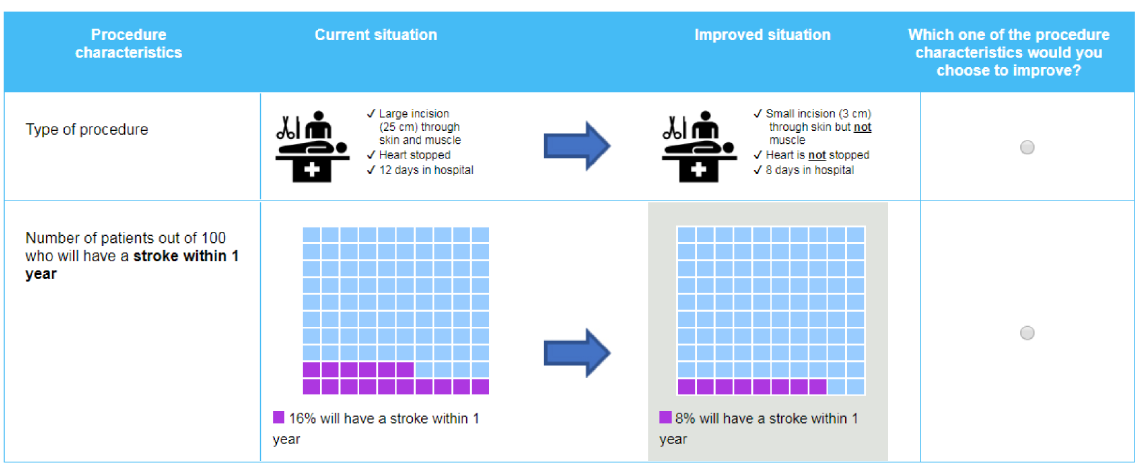
Figure 1. Example adapted swing weighting question presented to study participants. ‘ Type of Procedure’ was used in every pairwise comparison. Only the comparison attribute was varied across different attributes and performance levels.